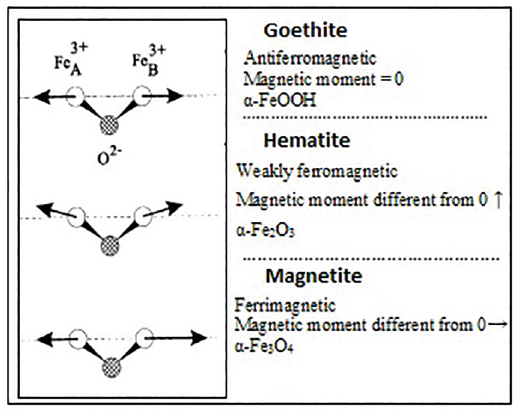
Figure 1. Magnetic structure of the main iron ore in Brazil 4 .